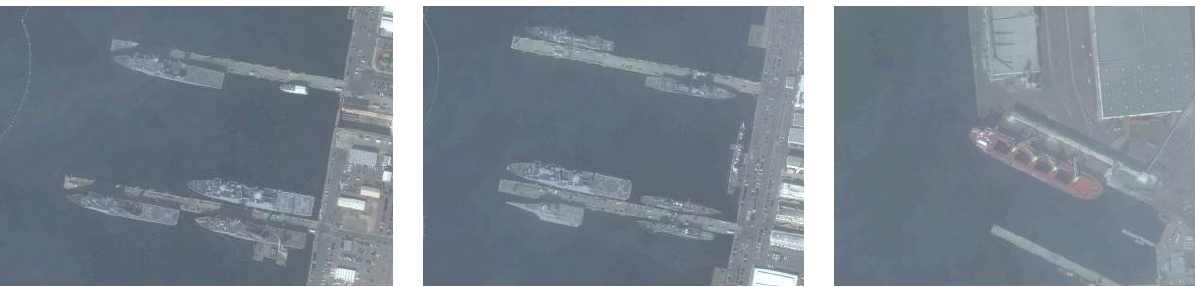
Figure 12. Images taken in foggy weather.